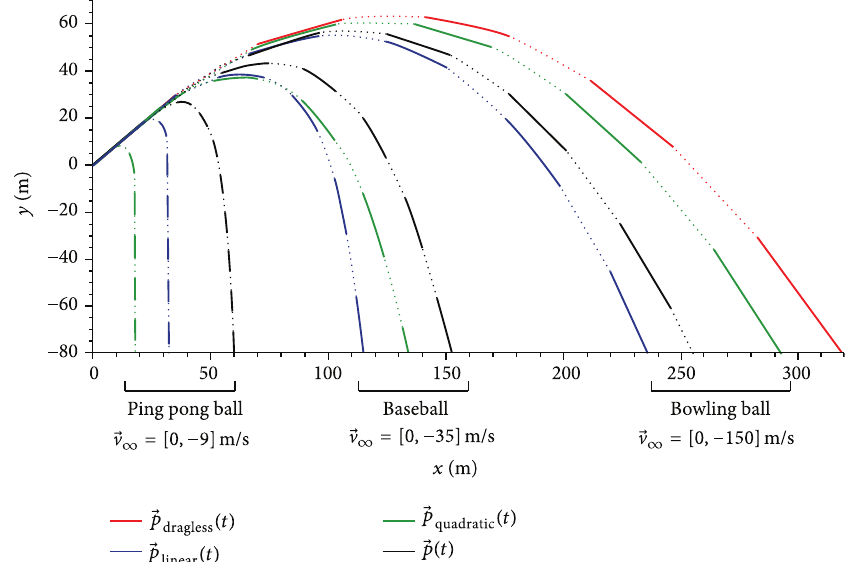
Figure 3: The trajectories resulting from four models for three different ball types.